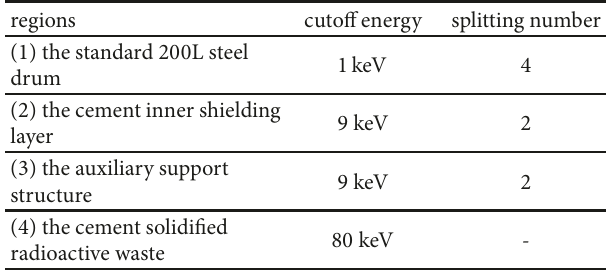
Table 2: The cutoff energy and Russian roulette splitting setting.